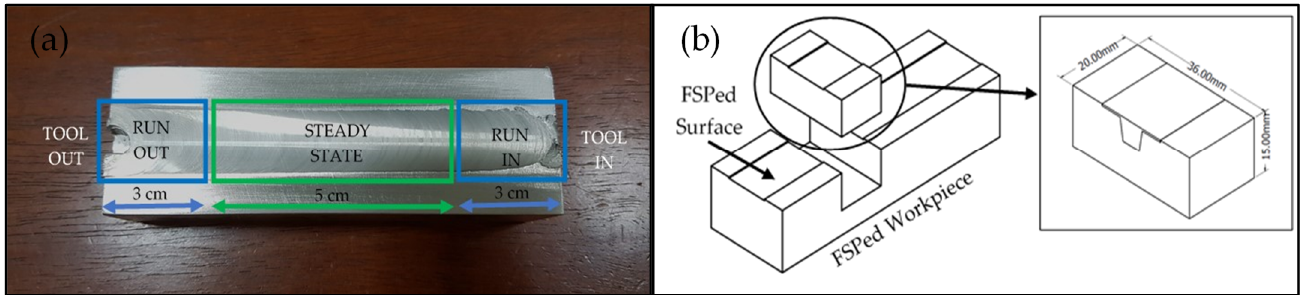
Figure 4. ( a ) Steady-state region of FSPed surface and ( b ) schematic diagram of testing sample for microhardness and microstructure test.